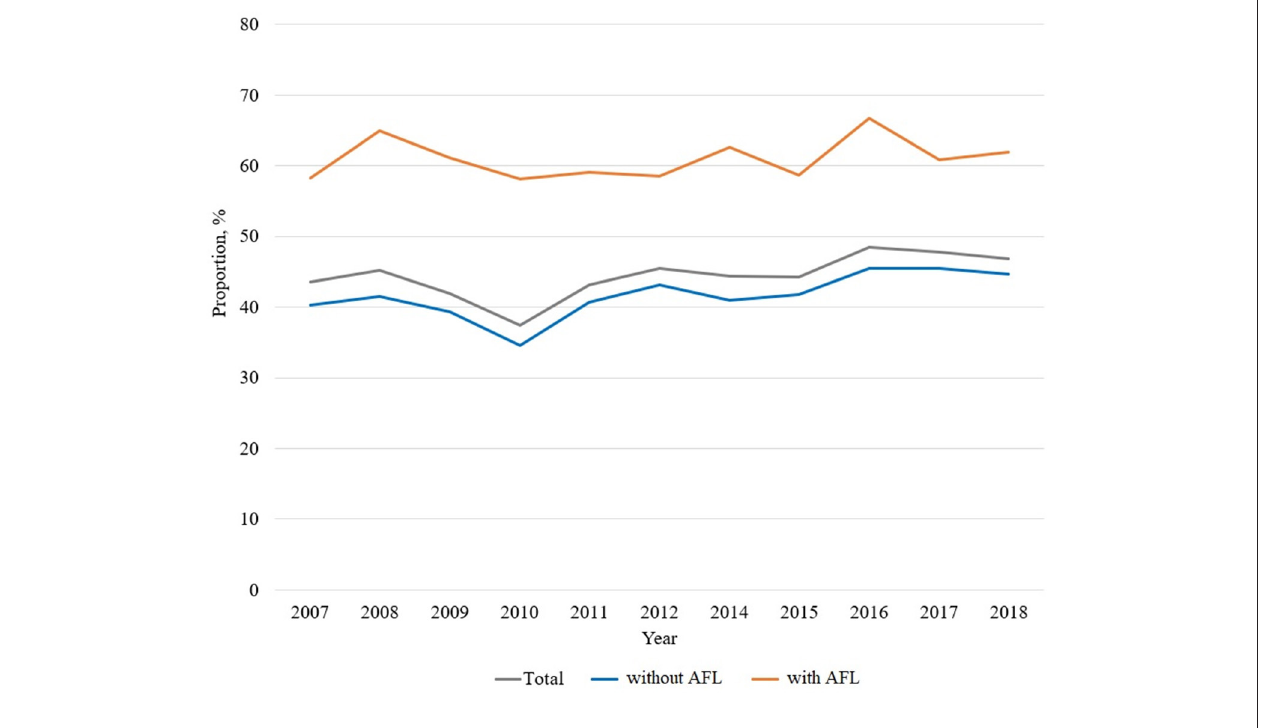
FIGURE 2 | Influenza vaccination trends in participants with AFL. AFL, airflow limitation.